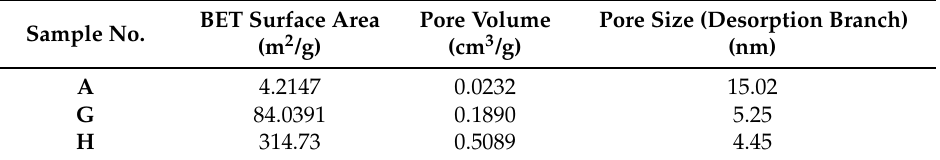
Table 2. Nitrogen physisorption